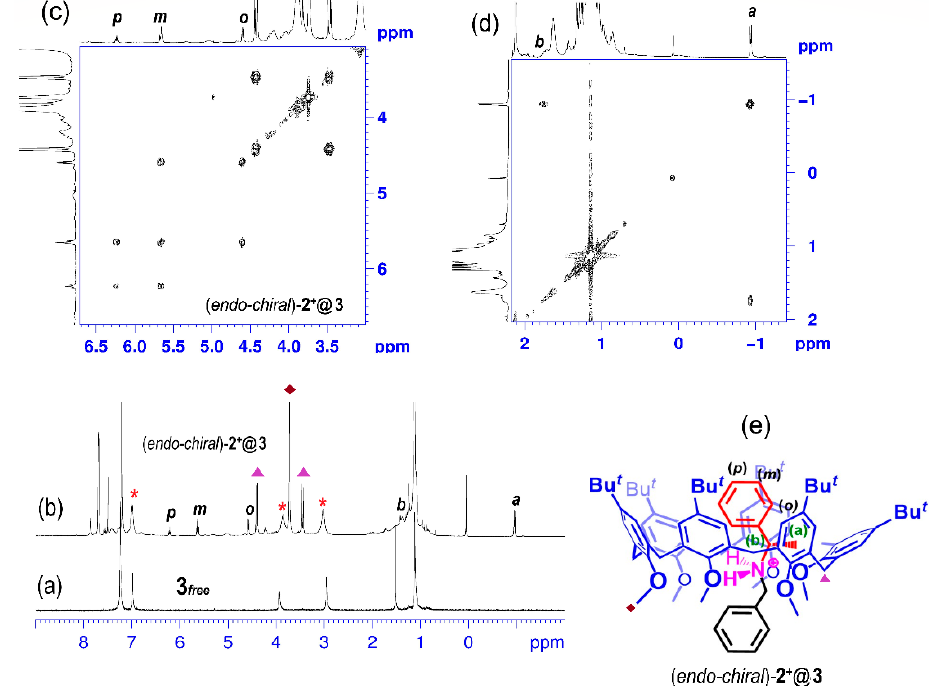
Figure 2. 1 H NMR spectra (600 MHz, 298 K, CDCl 3 ) of: ( a ) hexamethoxycalix[6]arene 3 ; ( b ) ( endo-chiral )- 2 + @3 pseudorotaxane; ( c , d ) Significant expansions of 2D COSY spectrum of ( endo-chiral )- 2 + @3 pseudorotaxane; ( e ) Chemical drawing of ( endo-chiral )- 2 + @3 pseudorotaxane.